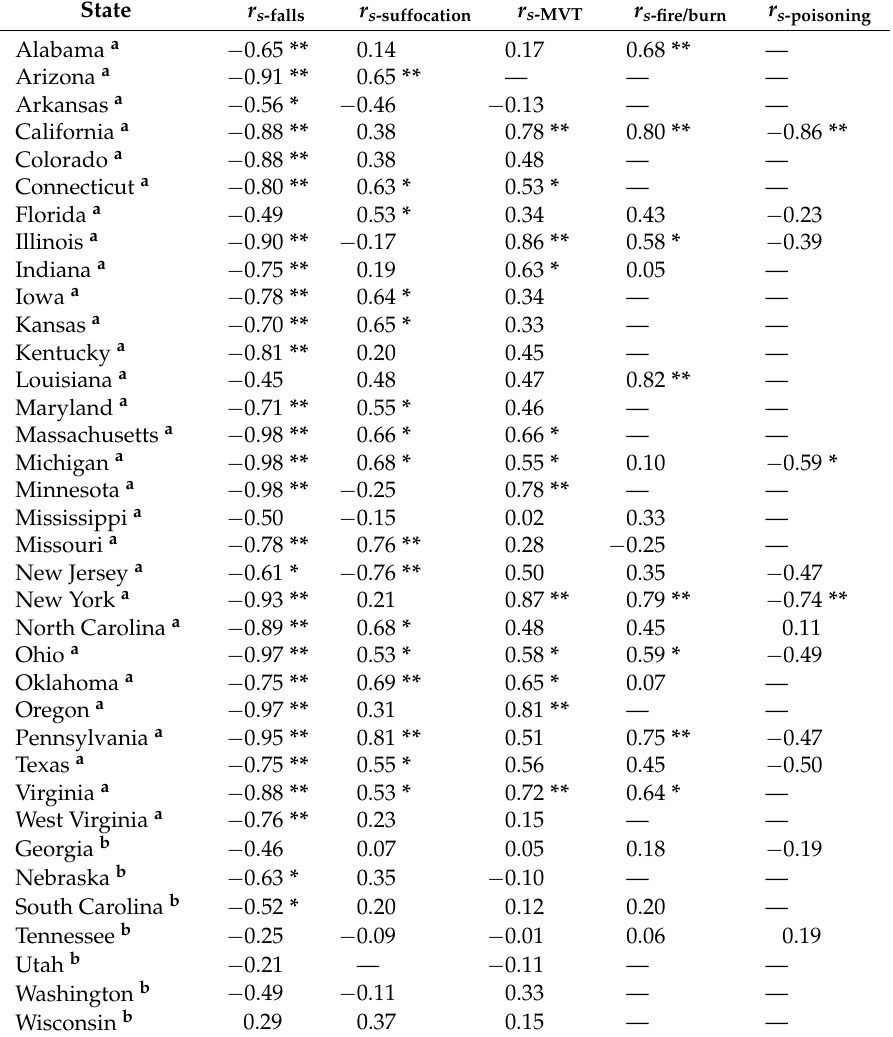
Table 2. Spearman correlation coefficients between unintentional injury mortality among individuals age 65 and over with unspecified cause and injury mortality from particular causes by state in the United States,